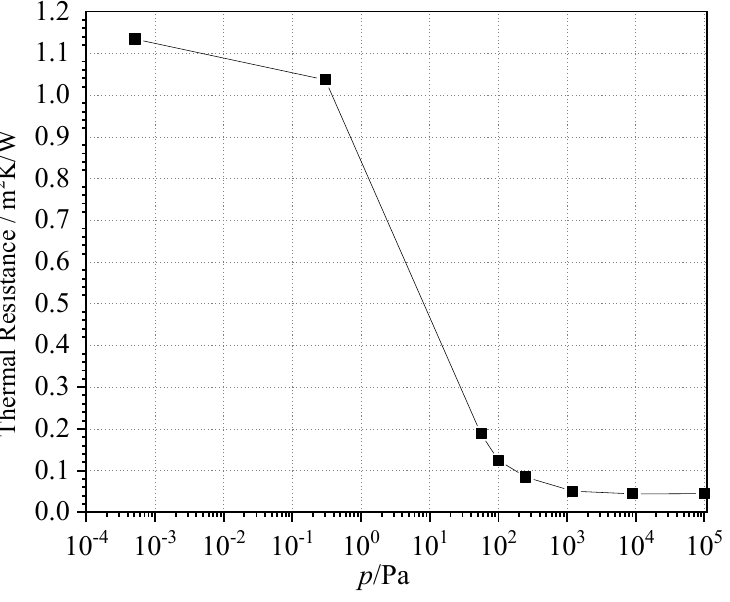
ature, 40 ◦ Figure 9. Thermal resistance of the new insulation material under different vacuum degrees; tem- perature, 40 °C.